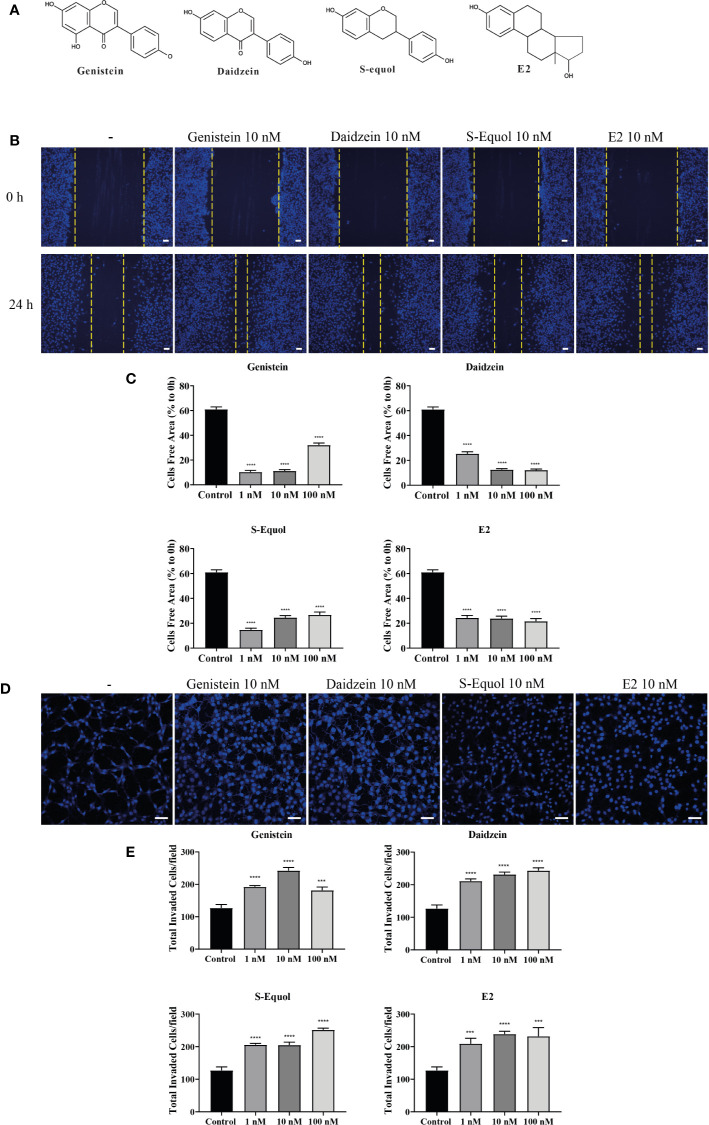
Effects of isoflavones on two-dimensional (2D) or three-dimensional (3D) cell migration. (A) Chemicals structures of isoflavones and E2. (B) Representative photomicrographs showing the effects of isoflavones on 2D wound healing assays using C6 cells. Live-cell staining was performed using Cellstain-Hoechst 33258 (Dojindo Molecular Technologies, Inc., Japan). (C) Quantitative analysis of the effect of isoflavones or E2 (1 – 100 nM) on cell migration measured by wound healing assay. (D) Representative photomicrographs showing the effects of isoflavone on 3D matrigel invasion assays using astrocytes. Cell nuclei were stained with DAPI. (E) Quantitative analysis of the effect of isoflavones or E2 (1 – 100 nM) on cell invasion measured by matrigel invasion assay. The total number of cells was quantified using ImageJ software (NIH). Bars represent 50 μm. Data are expressed as the mean ± SEM (n = 30 determinations) of at least three independent experiments. ****
p < 0.0001, ***
p < 0.001, indicates statistical significance measured using Bonferroni’s test compared with the control (−).